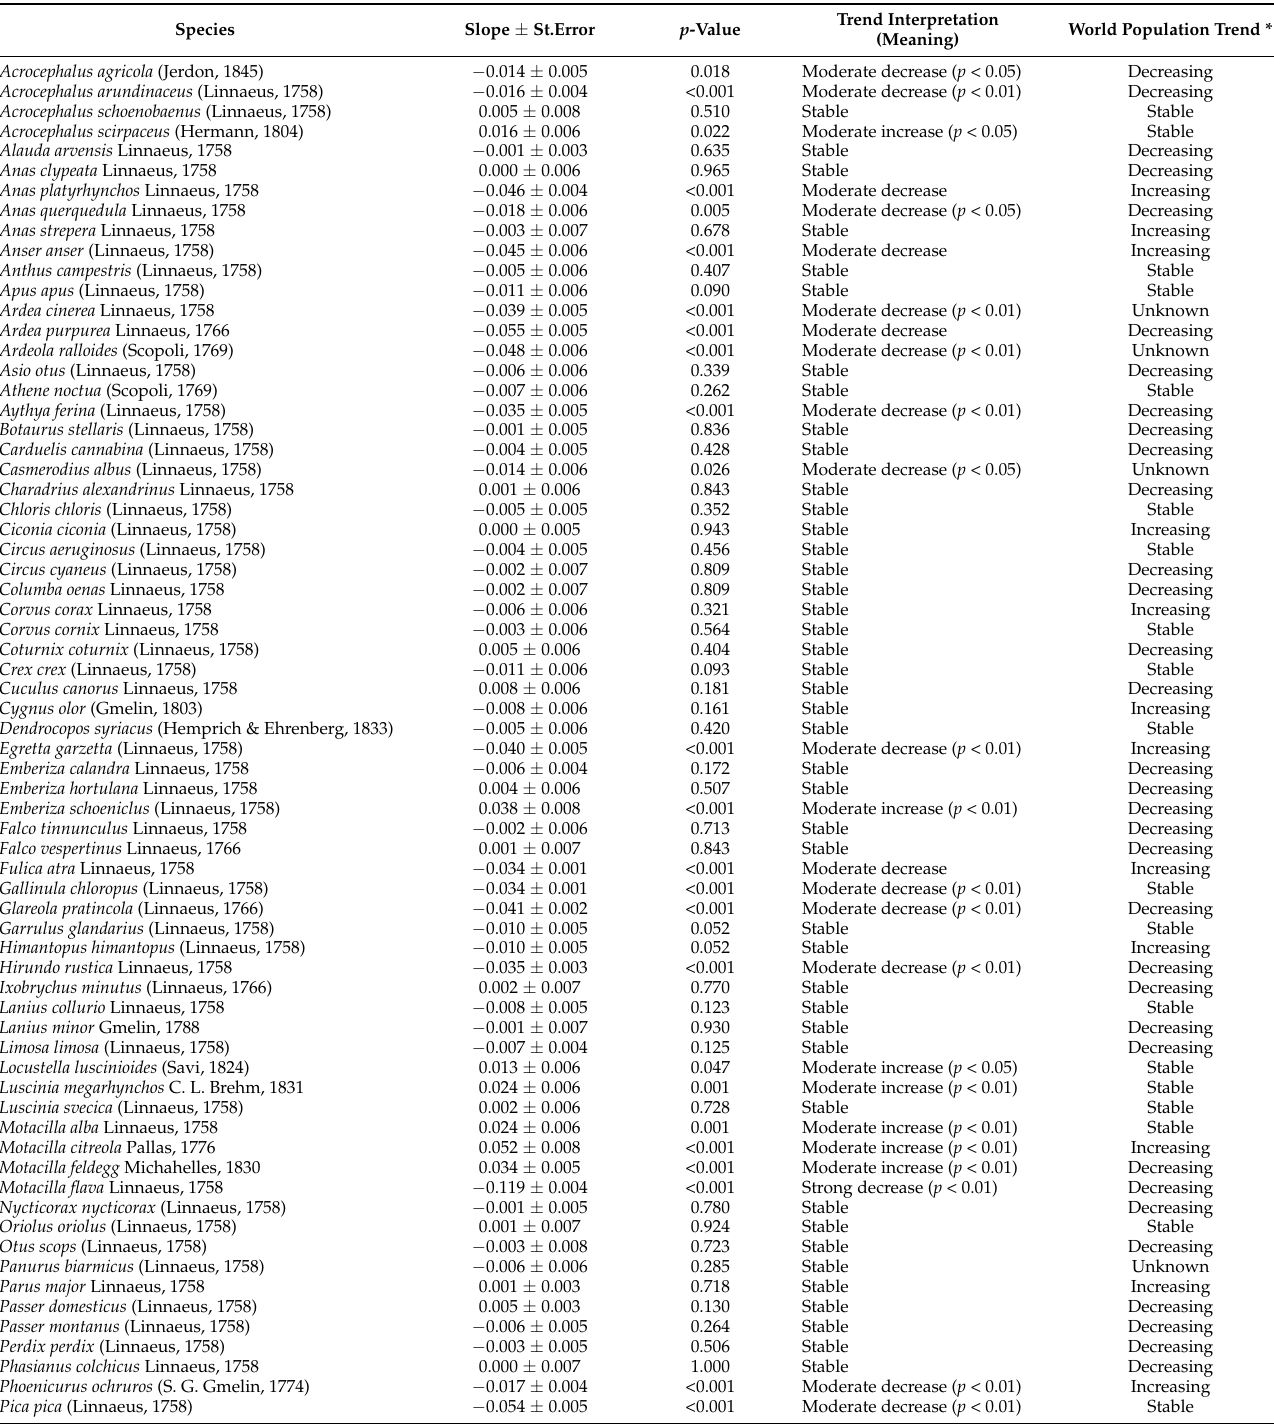
Table A4. Trends in the abundance of bird species (1988–2018). Trends in bird populations were classified, according to Pannekoek and van Strien [52], into one of the following categories depending on the overall slope and its 95% confidence interval: strong growth/steep decline is classified if growth/decline is significantly greater than 5% per year; moderate growth/decline is classified if growth/decline is significant, but not more than 5% per year; stable is classified if there is no significant increase or decrease and there is confidence that trends do not exceed 5% per year; and uncertain is classified if there is no significant growth or decline, but there is no certainty that trends are less than 5% per